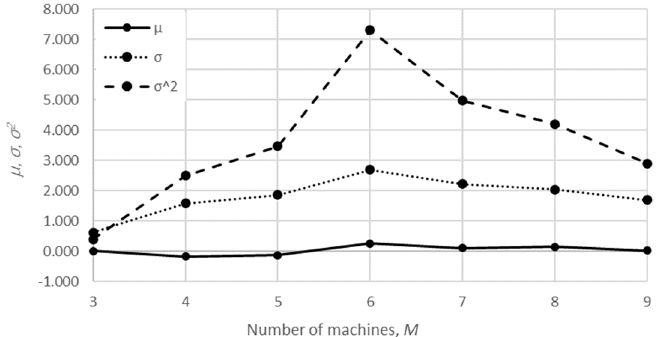
Figure 11. The relative error of the WIP concerning the number of machines—FSM.